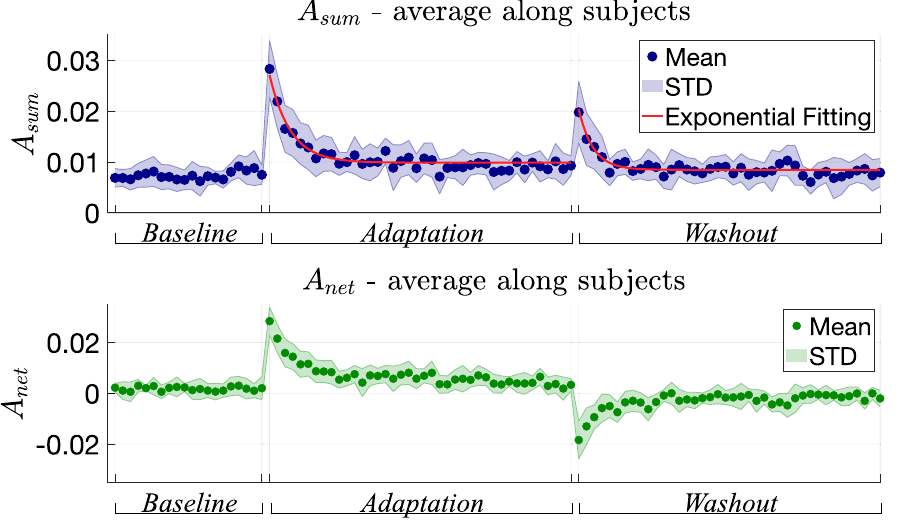
Figure 4. Behaviour of A sum and A net over trial. Moreover, the exponential fitting curve is superimposed on A sum data.